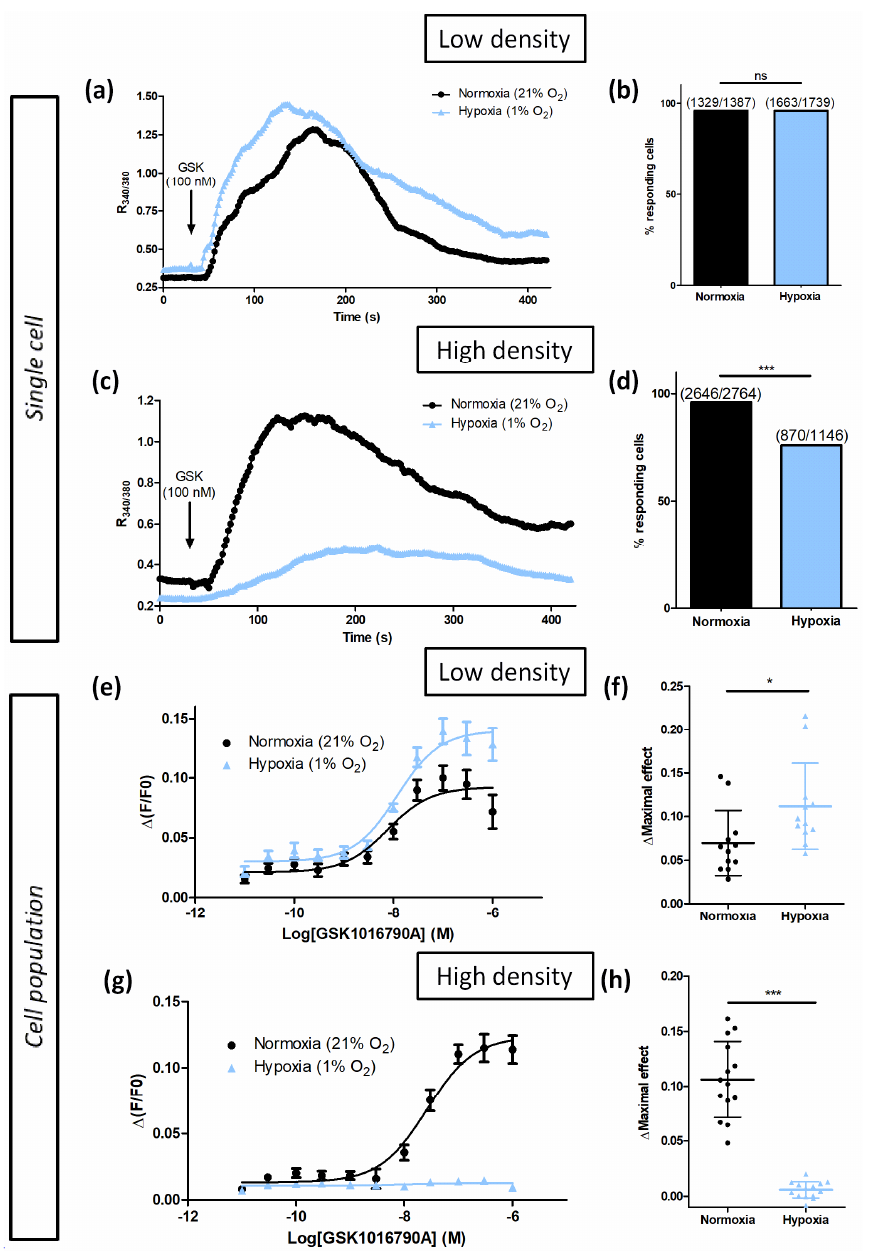
Figure 3. Hypoxia only potentiates TRPV4-induced Ca 2+ responses in transiently TRPV4-transfected HEK293T (HEK-TRPV4) cells cultured at low density (1 × 10 4 cells/cm 2 ). ( a – d ) Variations of relative cytosolic Ca 2+ concentration (Ratio R 340/380 ) were monitored by single-cell fluorescence videomicroscopy in Fura-2-LR/AM loaded cells grown under normoxia (21% O 2 ) or hypoxia (1% O 2 ) for 48 h. ( a ) Typical recordings of single cells when HEK-TRPV4 were bathed in physiological saline solution and GSK1016790A (GSK, 100 nM), a selective TRPV4 agonist, was added at 30 s (as indicated by the arrow), and ( b ) percentage of responding cells in response to GSK at low density.